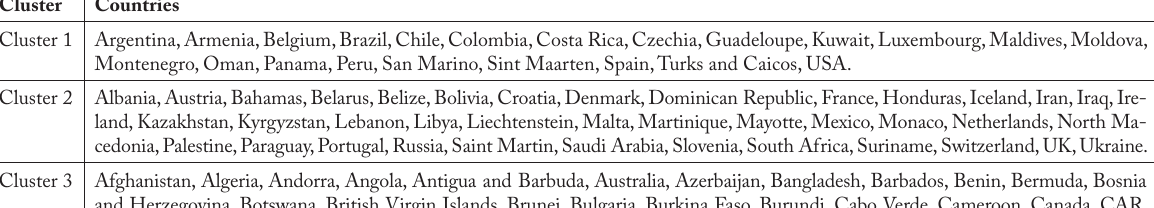
Table 3. Cluster memberships of countries according to the k-means